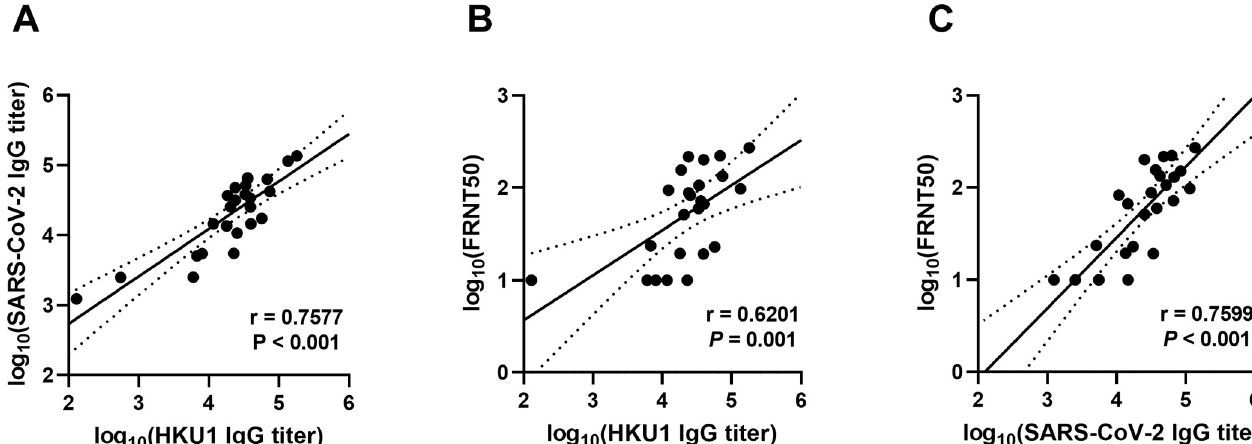
Fig 4. HKU1 spike IgG antibodies correlated positively with both SAR-CoV-2 spike IgG and SARS-CoV-2 neutralizing antibodies in children with acute COVID-19 and MIS-C. Linear regression analyses compared the log-transformed antibody titers of (A) SARS-CoV-2 spike IgG vs. HKU1 spike IgG; (B) HKU1 spike IgG vs. SARS-CoV-2 neutralization titers; and (C) SARS-CoV-2 spike IgG vs. SARS-CoV-2 neutralization titers among children with acute COVID-19 or MIS-C. Spearman’s correlation coefficients (r) are shown.